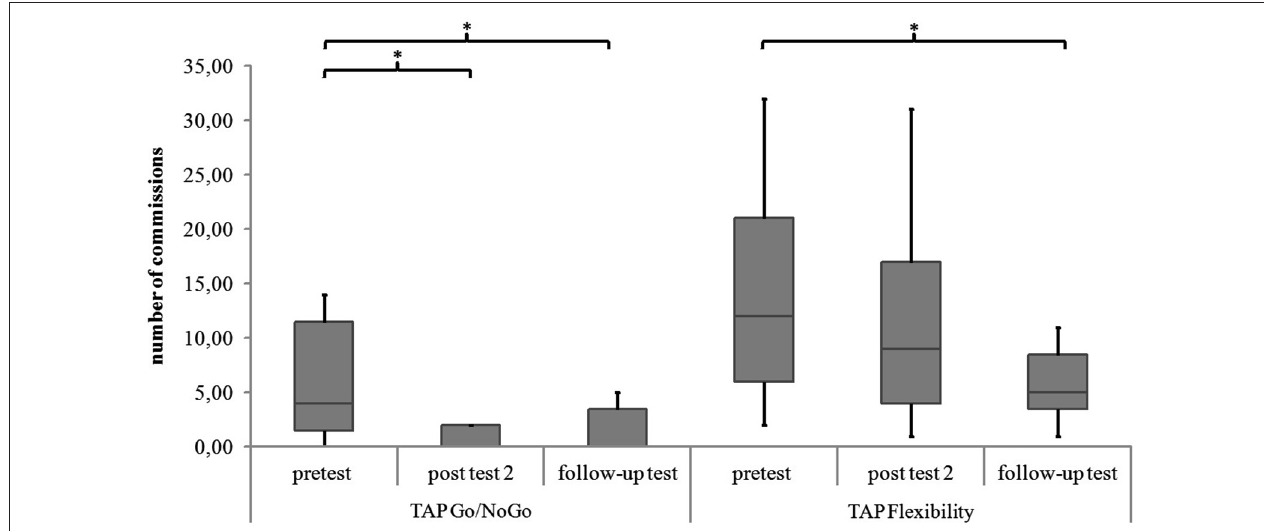
FIGURE 7 | Commissions in the TAP subtests Go/NoGo and Flexibility for all measurement points . Middle line of boxes = median, box = interquartile range, error bars = minimum respectively maximum, * = significant.